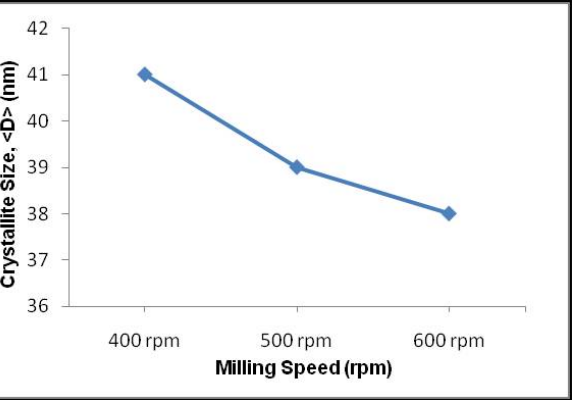
Figure 7. The effect milling speed on crystal size [80] (Permission obtained to use the figure from UTM eJournal Editorial Team via email).